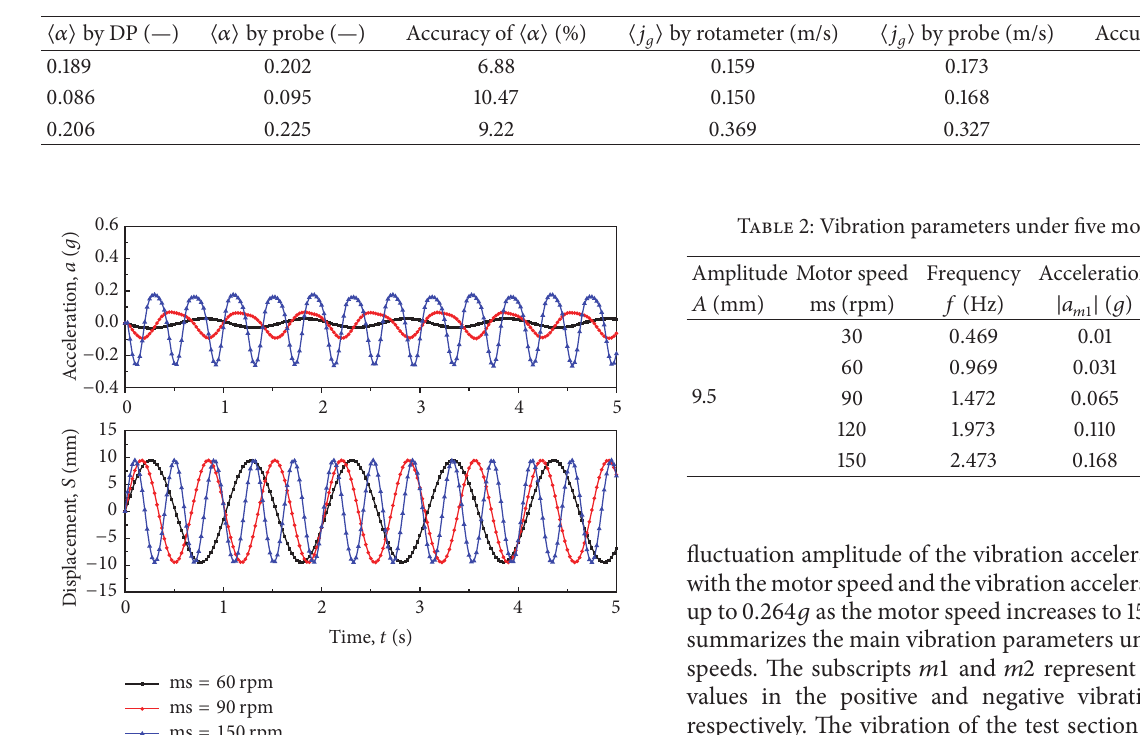
Table 1: Accuracy of probe measurement.